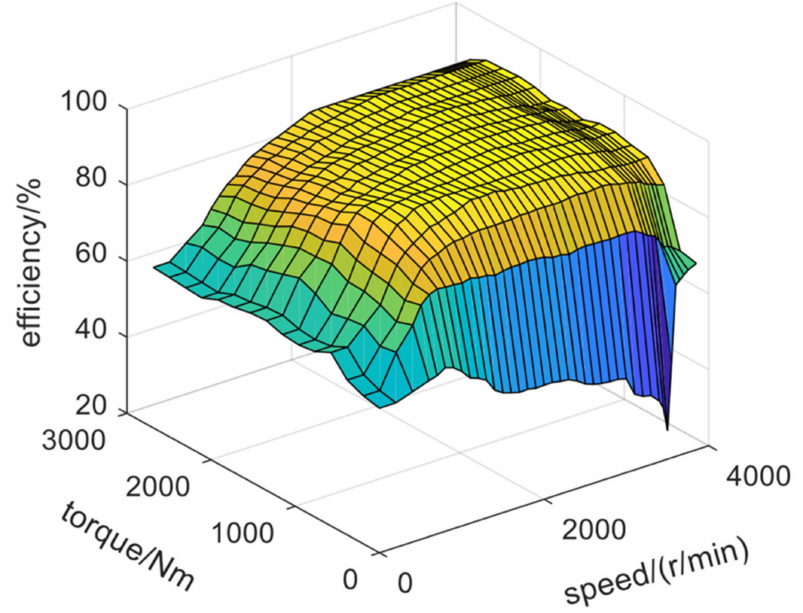
Figure 15. Efficiency of the traction